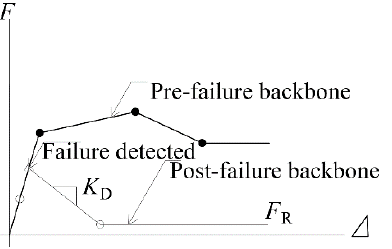
Figure 4. Backbone curve of shear – bending interaction model (shear limit curve) [17].